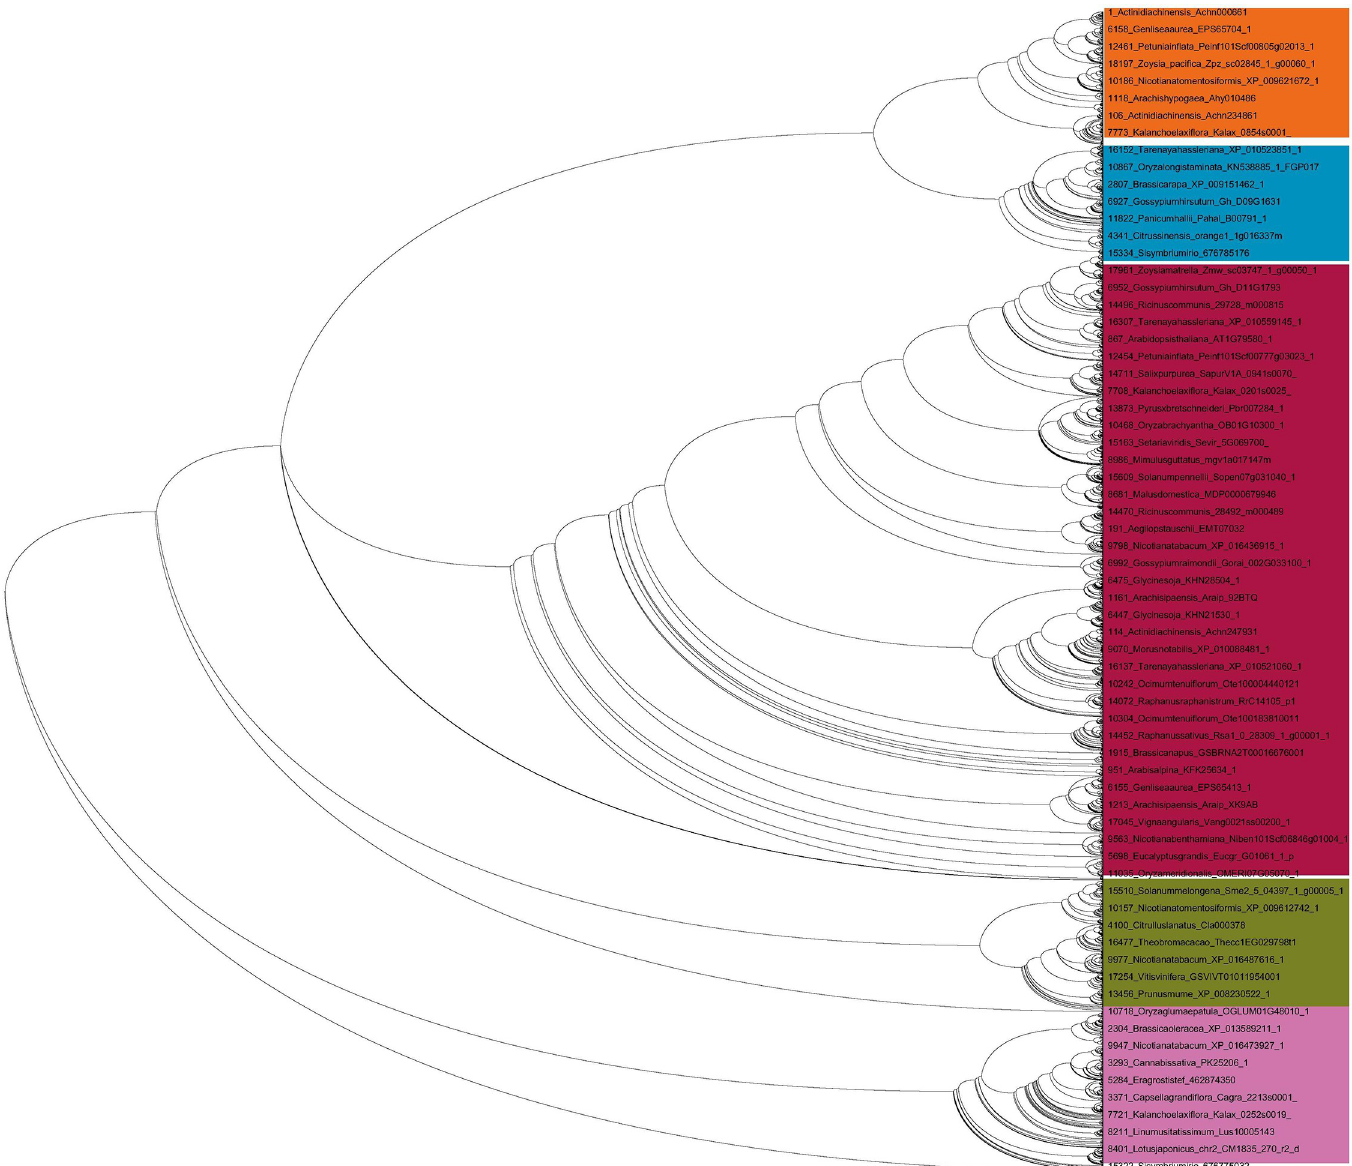
Fig 7. Phylogenetic tree of NAC TFs. A phylogenetic tree of NAC TF reveals the presence of seven clustered orthologous groups (COGs). Each group also possesses two or more sub-groups. The phylogenetic tree shows lineage (monocot/dicot) specific grouping of NAC TFs. The phylogenetic tree was constructed using the neighbour- joining method with 1000 bootstrap